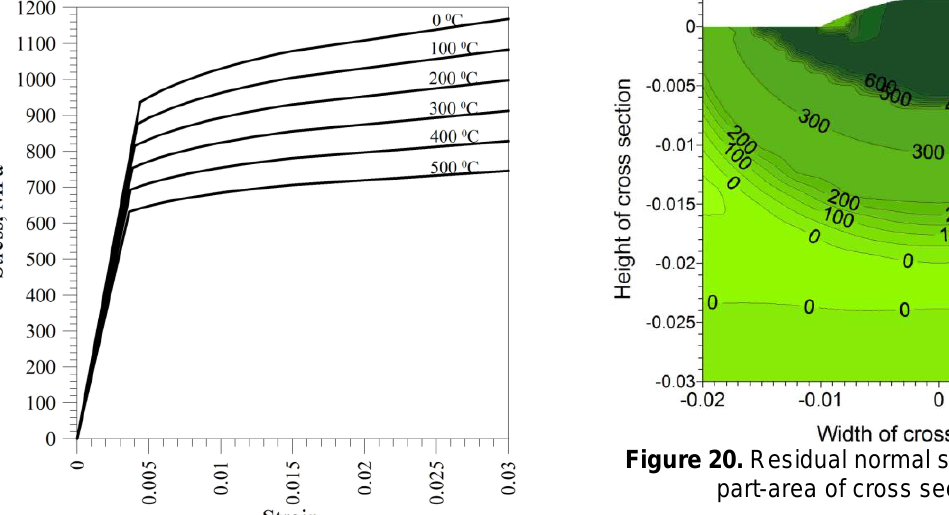
Figure 19. Tensile curves of martensite